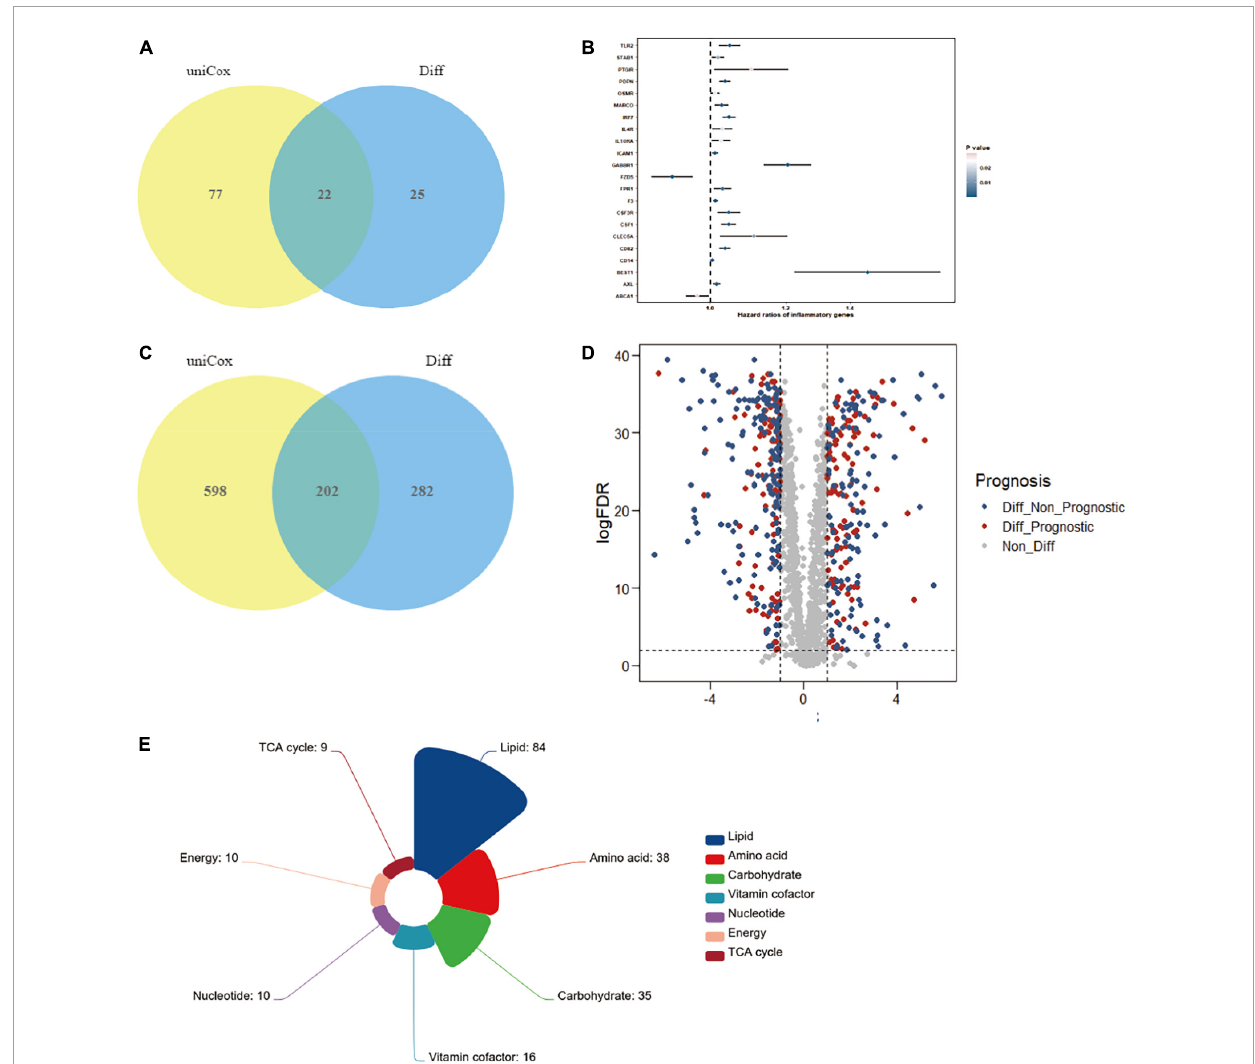
FIGURE4 Bioinformatics analysis was applied to explore the association of gut microbiota and ccRCC tumorigenesis. (A) A total of 22 inflammatory transcripts were selected based on overlap between univariate Cox regression and different expression analysis; uniCox, univariate Cox regression analysis; Diff, different expression analysis. (B) The prognostic analyzes of 22 inflammatory transcripts by univariate Cox regression model. (C) A total of 202 metabolism-related transcripts were selected based on overlap between univariate Cox regression and different expression analysis. (D) Volcano plots selected 202 metabolism-related genes with significant prognosis from 484 different expression genes. (E) The 202 selected metabolism-related genes were clustered into 7 metabolism